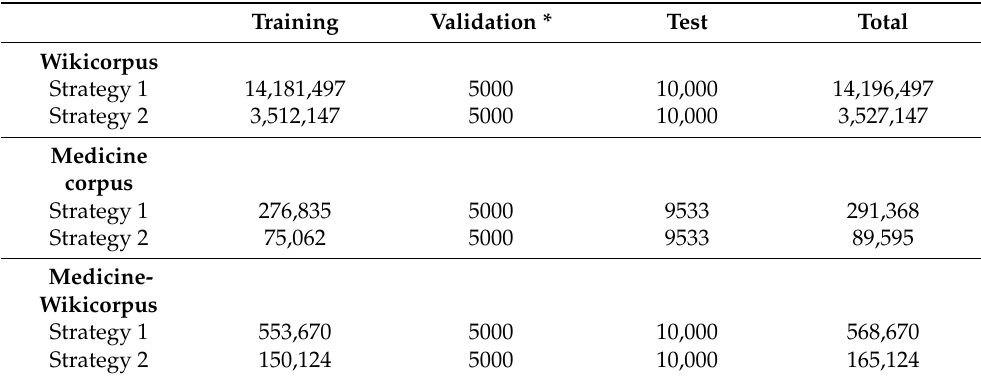
Table 6. Evaluation datasets